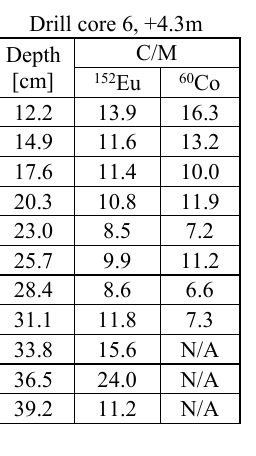
Table 2. Drywell Activation Validation Results